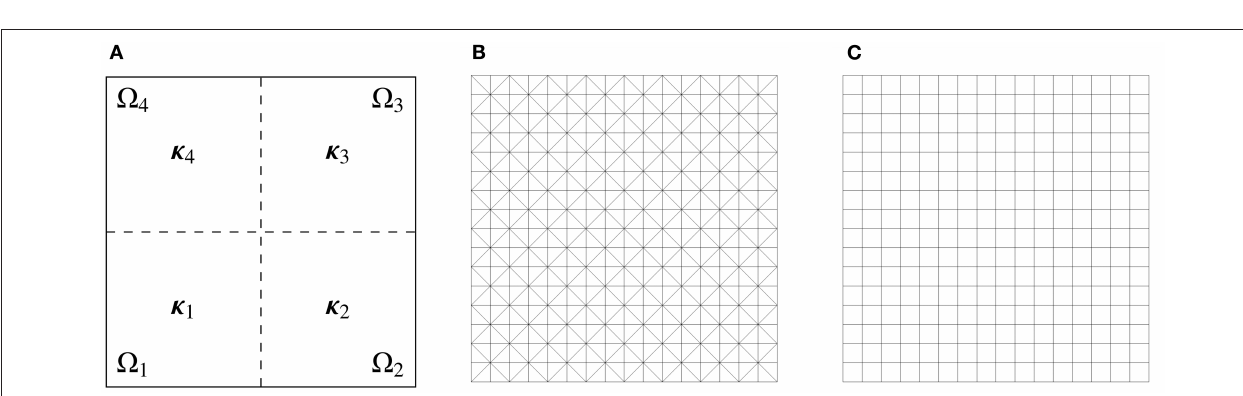
FIGURE 4 | Description of the test case with genuine anisotropy and heterogeneity properties with the four subdomains (A) . Uniform triangular (B) and rectangular (C) meshes with h = 1 /